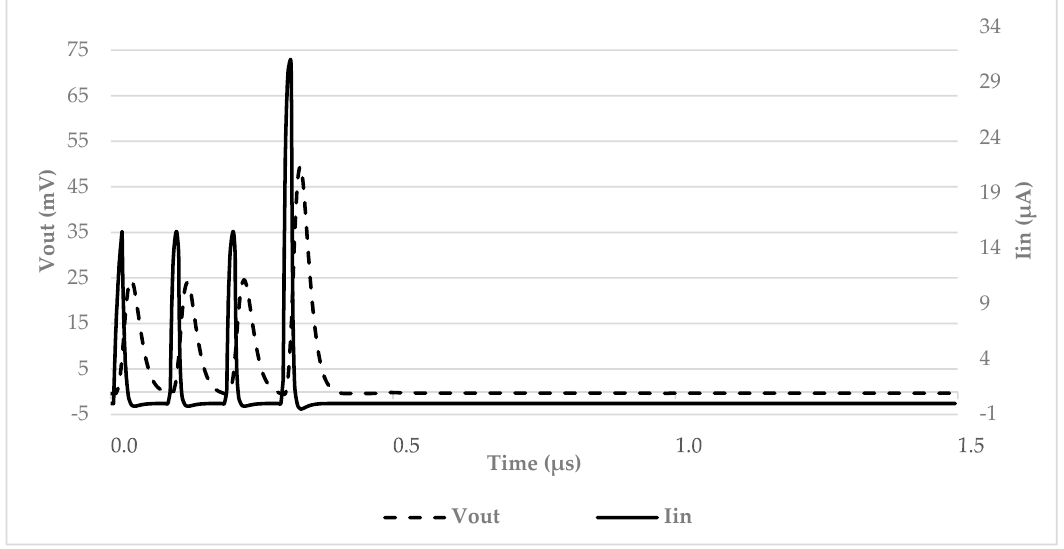
Figure 7. Time domain response of the interface to a train of SiPM current pulses at different amplitude levels.